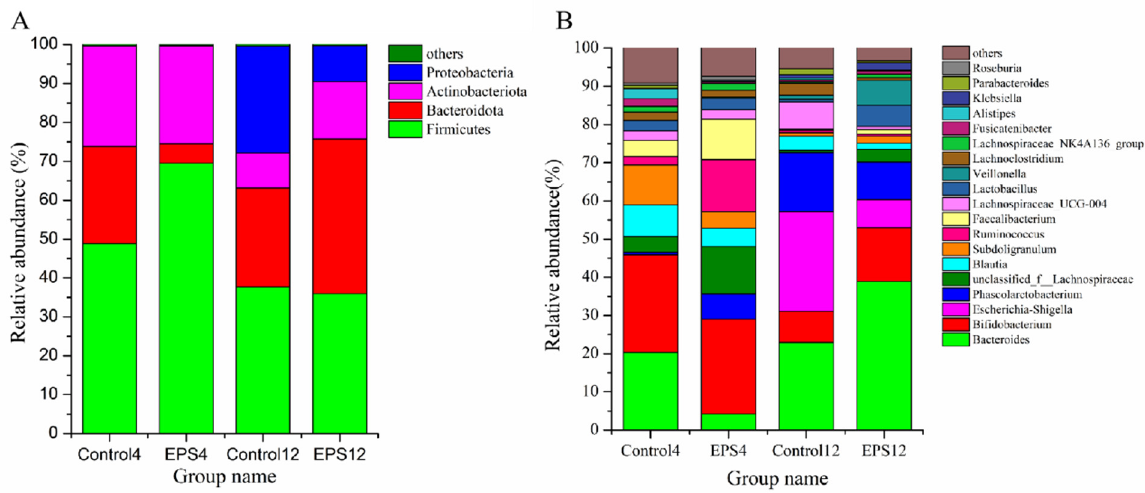
Figure 12. Comparison of fecal microbiota as affected by the EPS produced by Lpb. plantarum NMGL2 at the phylum level ( A ) and genus level ( B ) after incubation of the samples for 4 h (Control4 and EPS4 groups) and 12 h (Control12 and EPS12 groups).